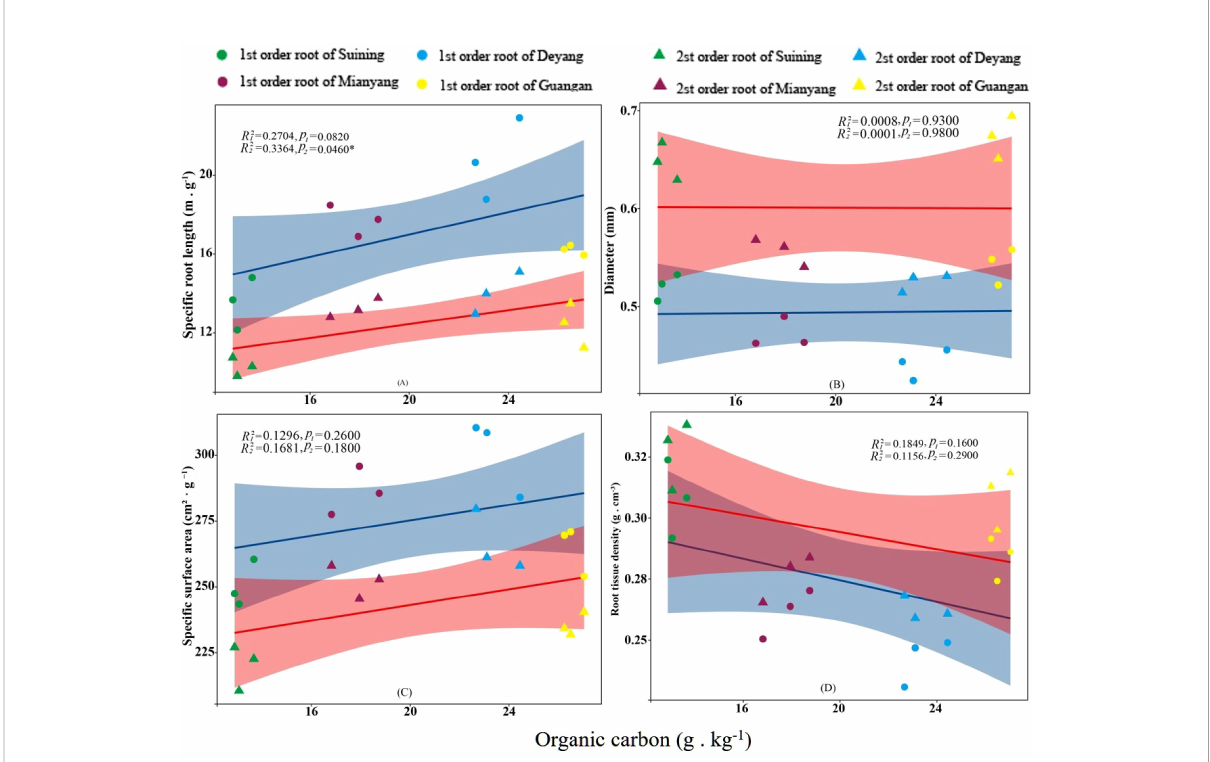
FIGURE 4 Effects of soil organic carbon on speci fi c root length, root diameter, speci fi c root surface area, and root tissue density at four research sites. R 12 and R 22 represent coef fi cients of determination for regressions of fi rst- and second-order fi ne roots *and **indicate signi fi cance at p < 0.05 and p p- values indicating signi fi cance of regressions with fi rst- and second-order fi ne roots, respectively. The p < 0.01, respectively. p 1 and 2 are shaded part is the con fi dence interval of the fi tting line, regimes (n = 3 per